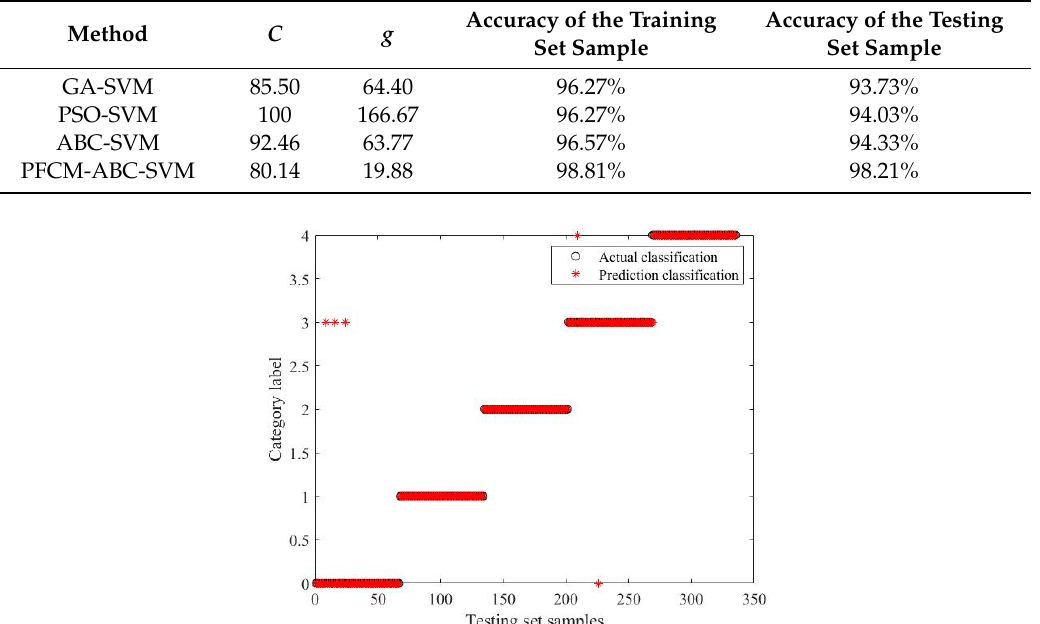
Table 5. The comparison between the PFCM-ABC-SVM method and the other methods.